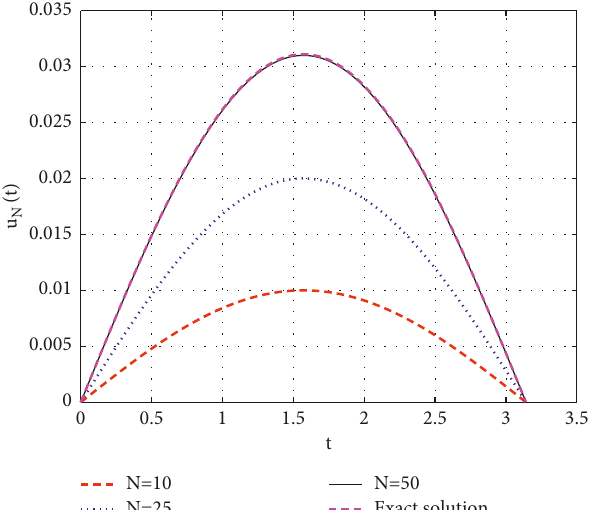
Figure 3: The graphs of the numerical solutions by using the proposed method for Example 1 with different values of N and the exact solution.